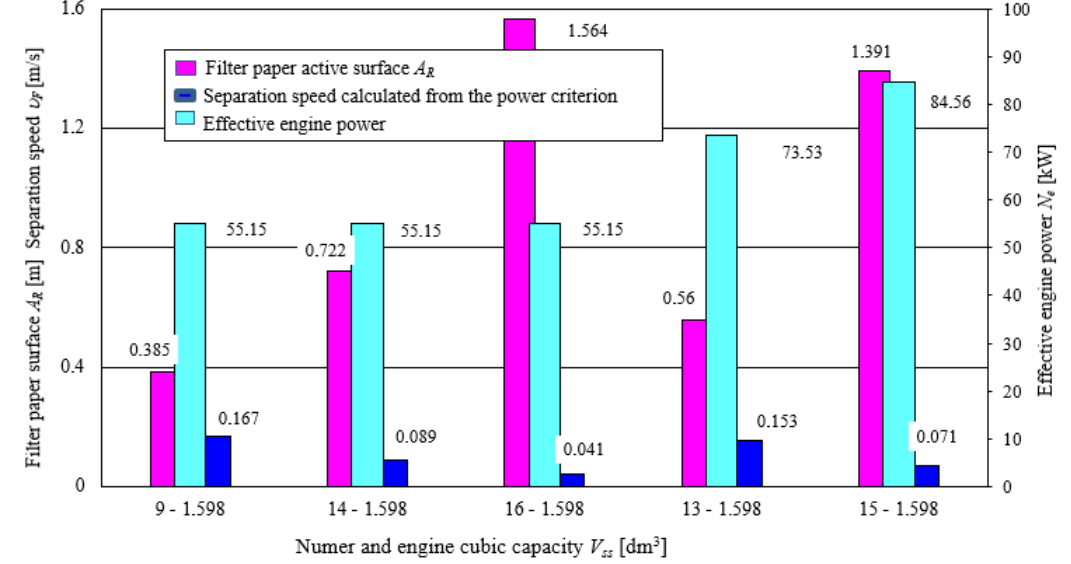
Fig. 9. Separation speed  N calculated from the power criterion and the actual separation area A R for passenger cars with cubic capacity V ss = 1.598 dm